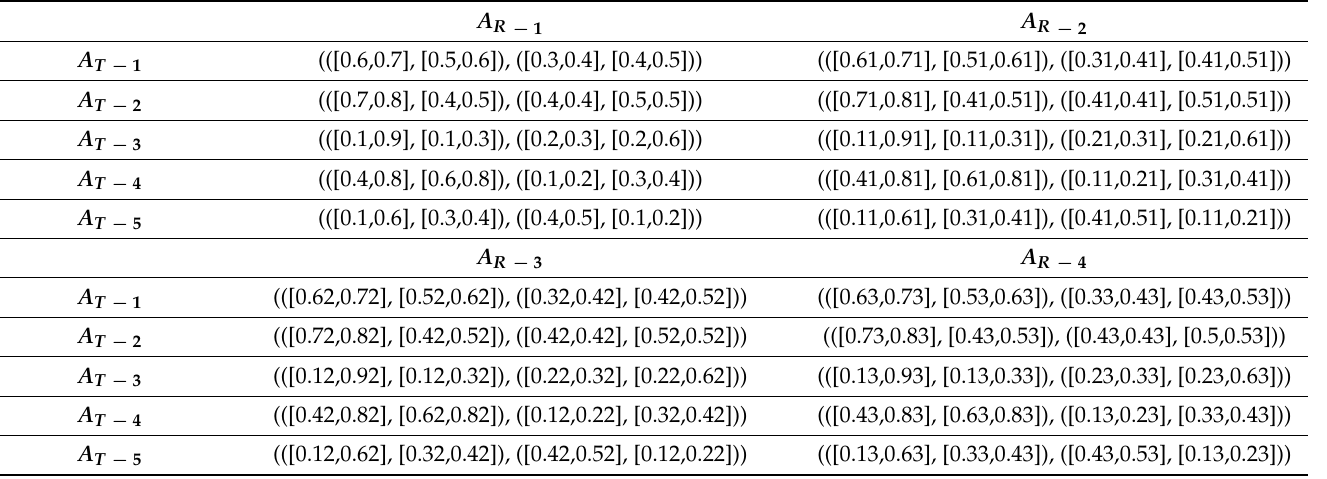
Table 2. Original decision